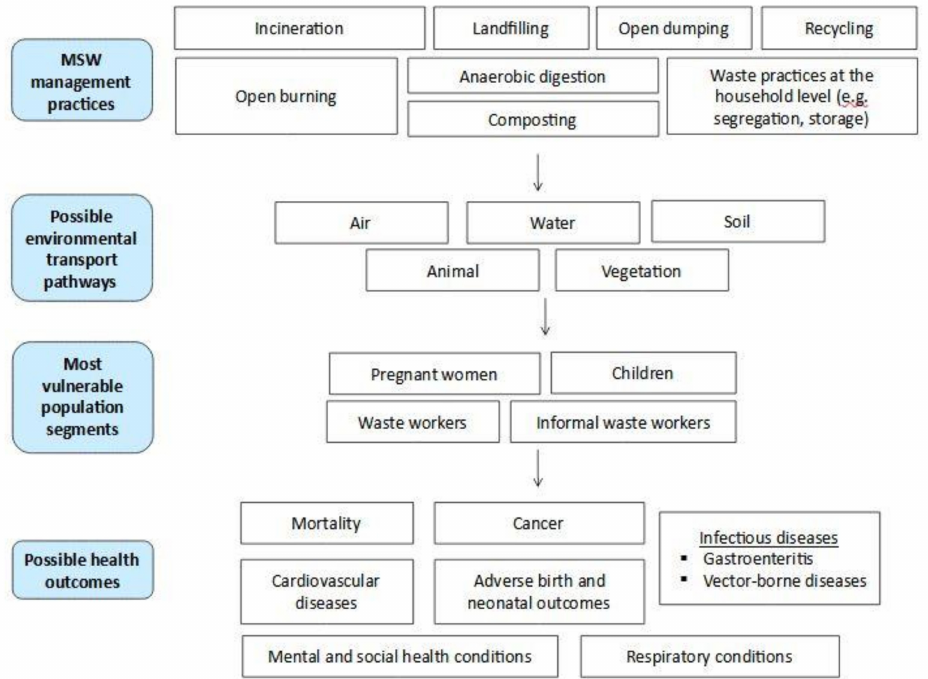
Figure 1. Schematic representation of the linkages between solid waste management practices and possible adverse health